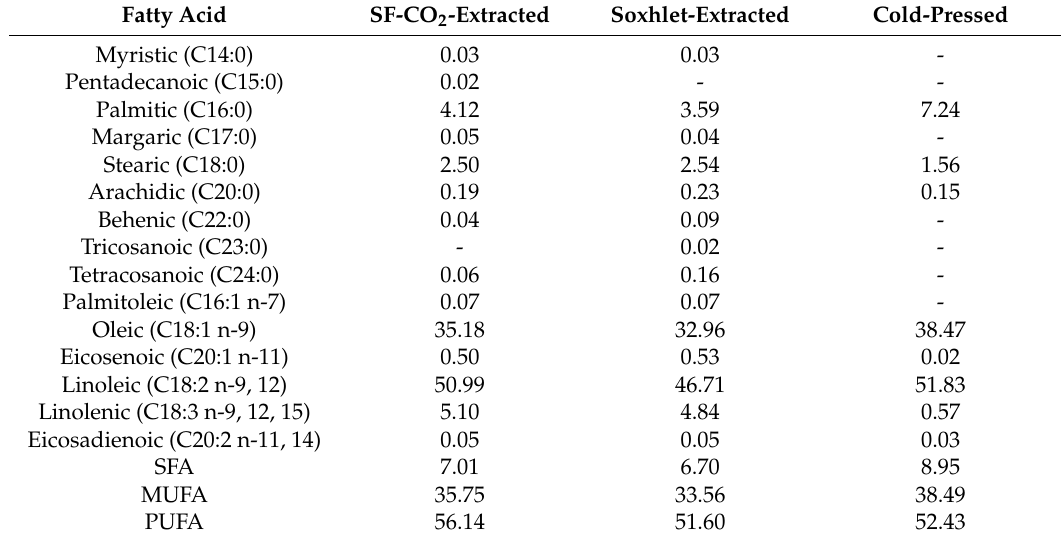
Table 3. Fatty acid composition of EDS oil extracted by different